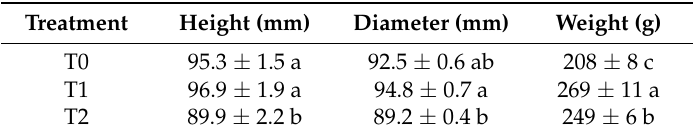
Table 1. Characterization of primary harvested heads according to the cutting type used for the artichoke vegetative propagation.